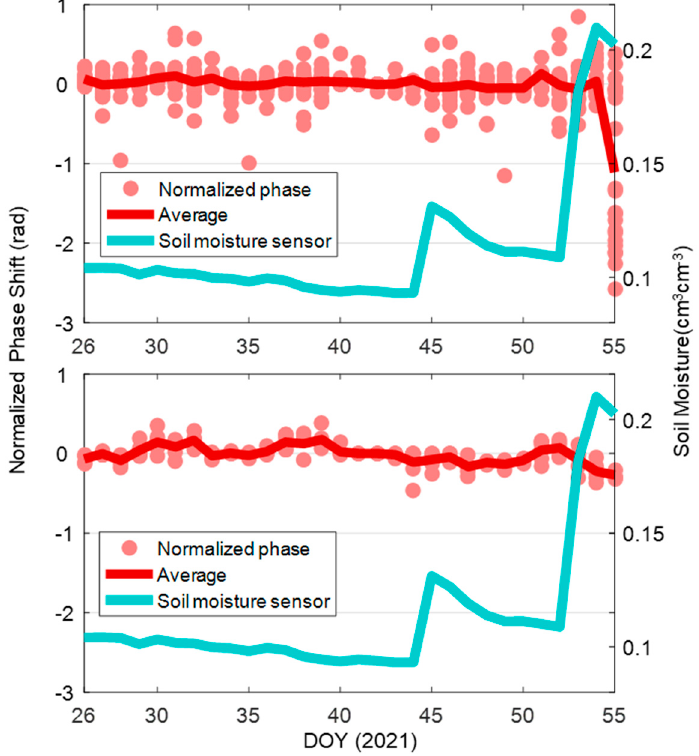
Figure 9. Normalized phase shift sequences of all BDS MEO satellite tracks and the phase shift average results: ( upper ) B1I results; ( lower ) B2I results.